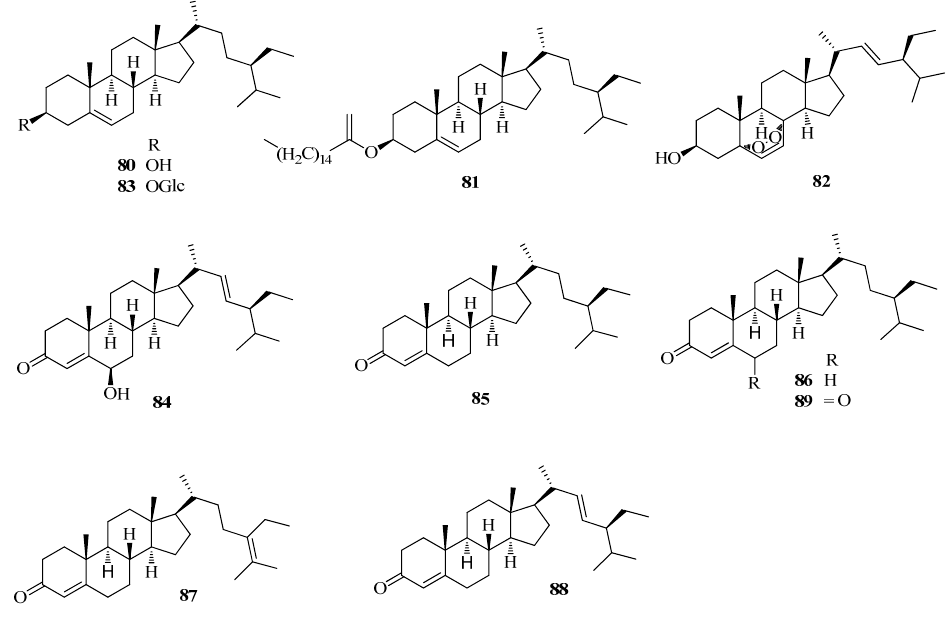
Figure 6. Structures of steroids isolated from F. esculentum , F. tataricum and F. diabotrys .